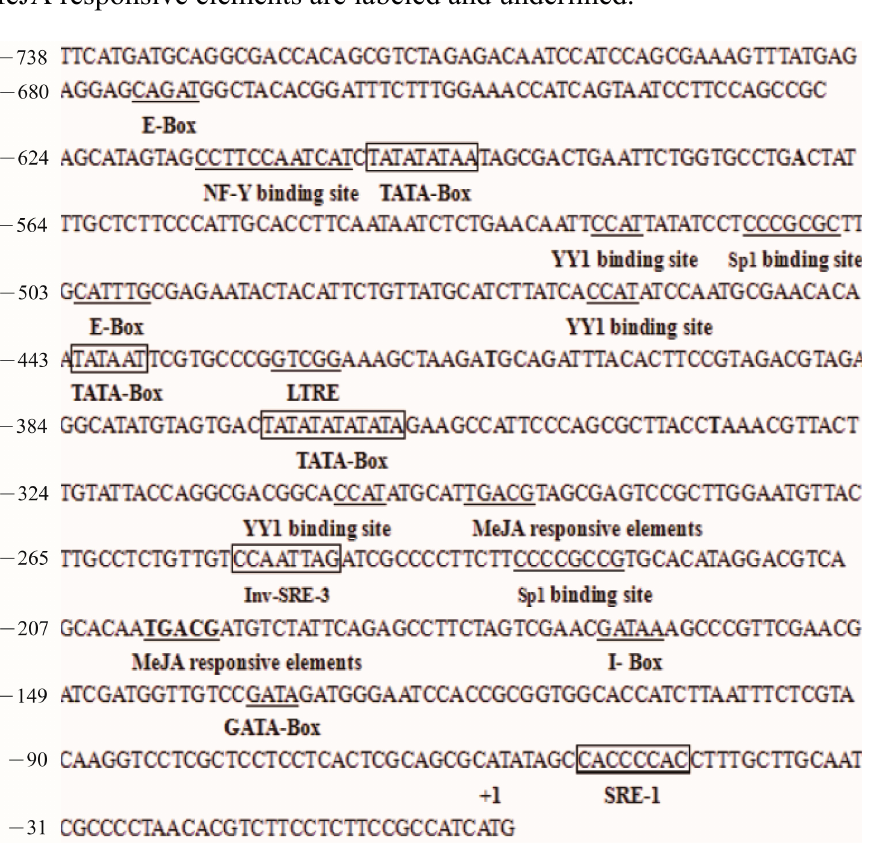
Figure 2. Nucleotide sequence of the promoter region for the Pc-fps promoter. The translational start site ATG was defined as position +1. The transcriptional regulatory elements of TATA-box, Sp1 binding site, NF-Y binding site, E-box motif, YY1 binding site and MeJA responsive elements are labeled and